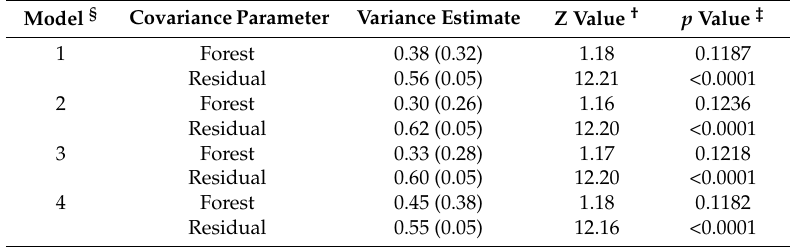
Table 3. Estimates of covariance parameters and their significance for the different